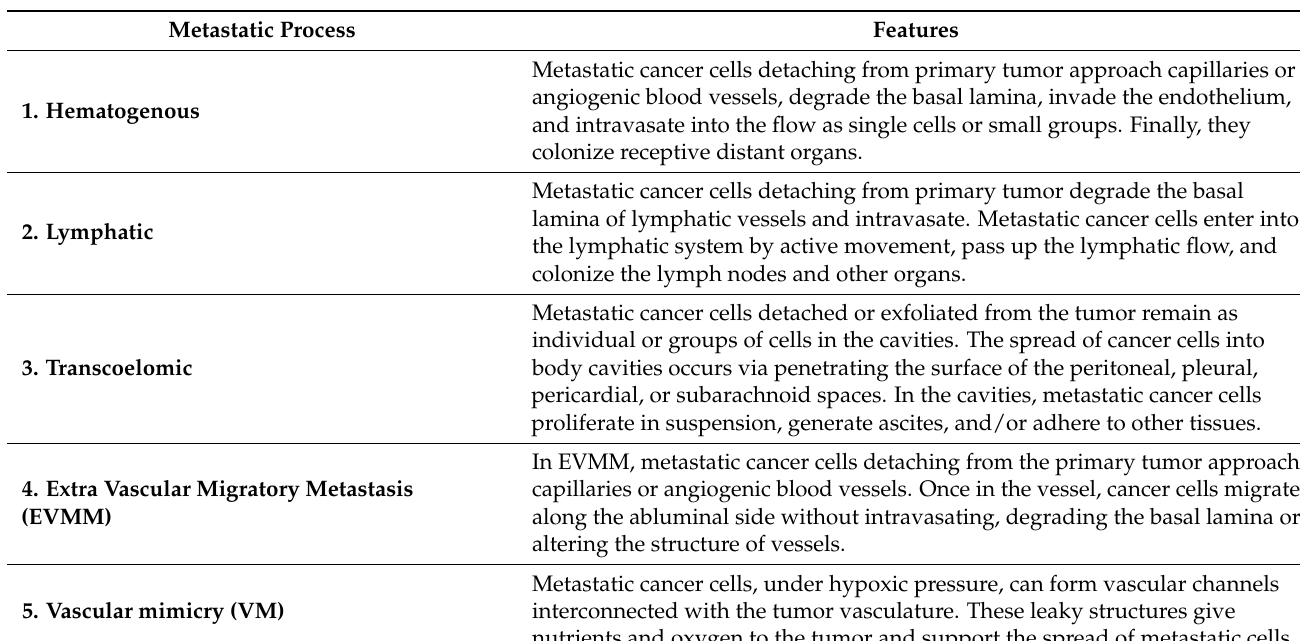
Table 1. Short description of the different routes of cancer